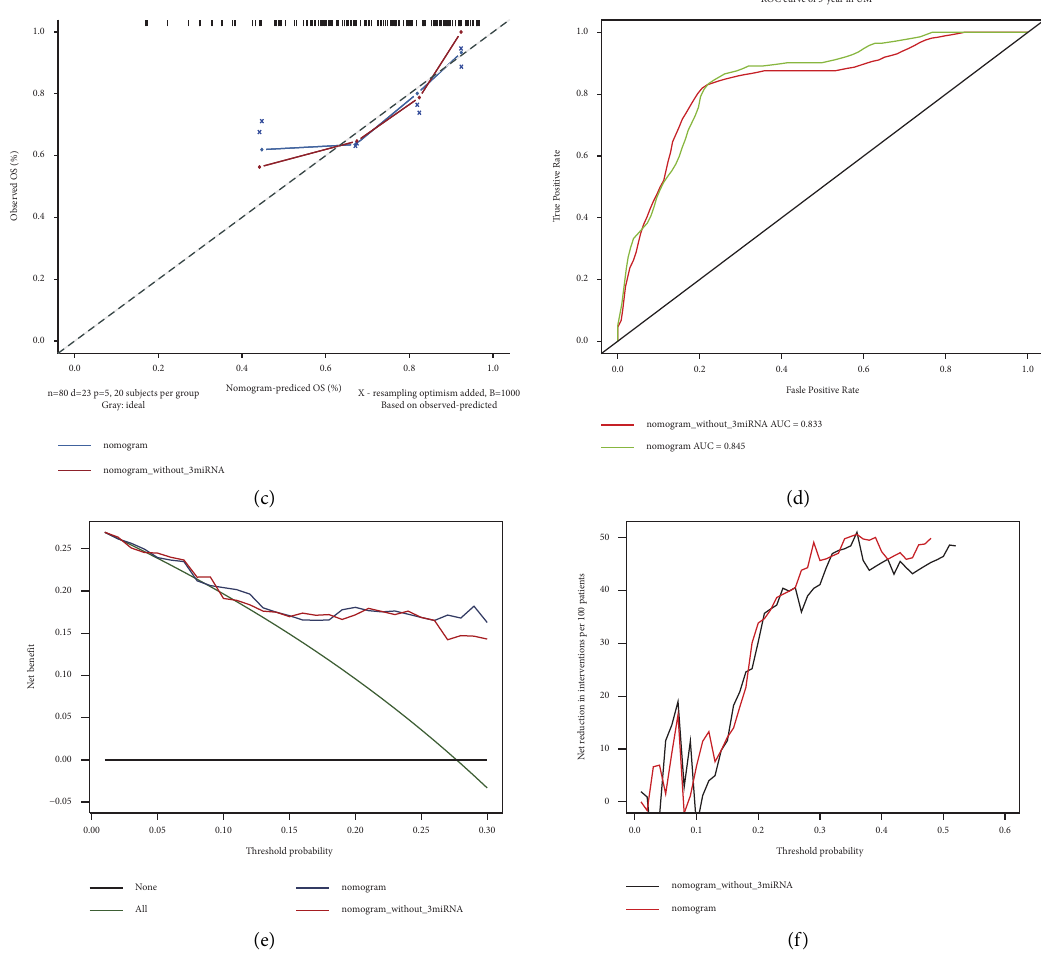
Figure 5: Nomogram construction for predicting overall survival in uveal melanoma. (a): Te nomogram composed by the 3-miRNA score, stage, TNM, age, and gender. Te total points were calculated by drawing a vertical line from variable values to the axis labelled “Points” which can predicted 1 and 3 years of overall survival (OS). (b): Calibration curves of the nomogram for predicting OS at 1 year (red solid line) and 3 years (blue solid line). (c): Calibration curves of the nomograms for predicting OS in without 3-miRNA model (red solid line) and 3-miRNA model (blue solid line). (d): ROC curve for the accuracy of nomogram. Te whole nomogram (green solid line) had higher accuracy than the nomogram model without 3-miRNA risk score (red solid line). (e): Decision curve of the nomogram for 3 years of OS. Te green line means the speculation that all patients survive in the 3 years. Te gray line means the speculation that no patients survive in the 3- year. Te red and blue line means the nomogram without 3-miRNA model and integrated nomogram model respectively. (f): Te net reduction curves of the nomogram without 3-miRNA model (black solid line) and nomogram model (red solid